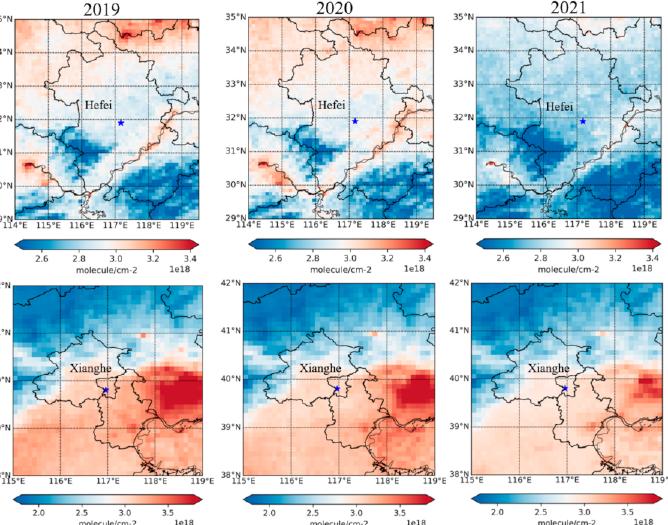
Figure 5. The distributions and variations in the annual means of TROPOMI CO total column around Hefei and Xianghe from 2019 to 2021.